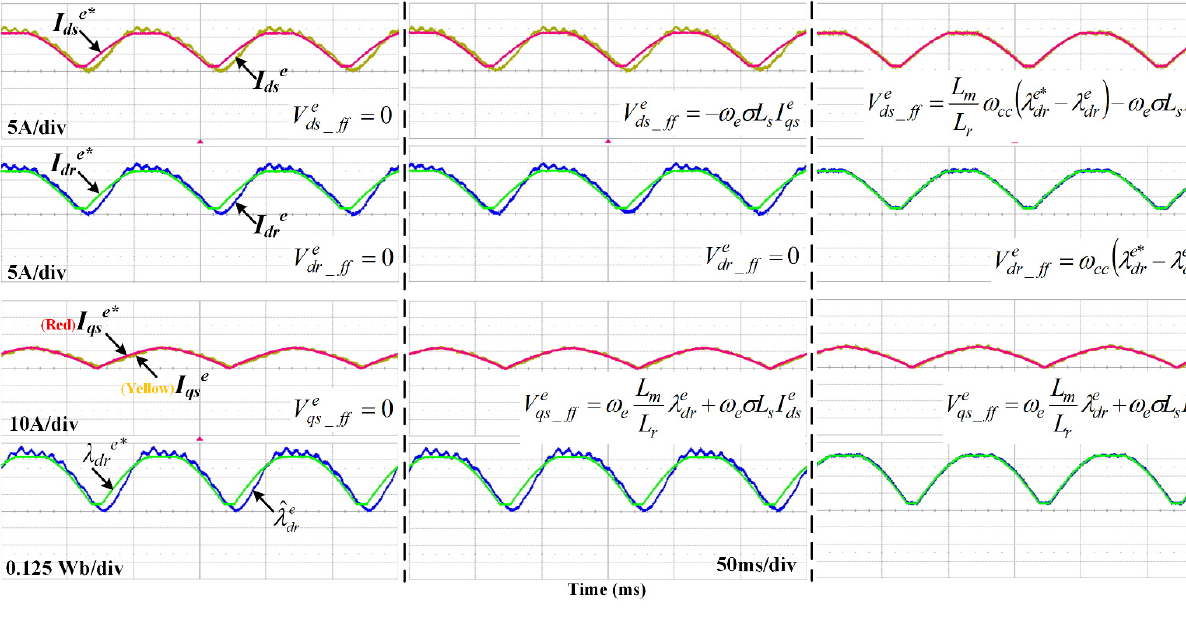
( a ) Figure 11. Cont